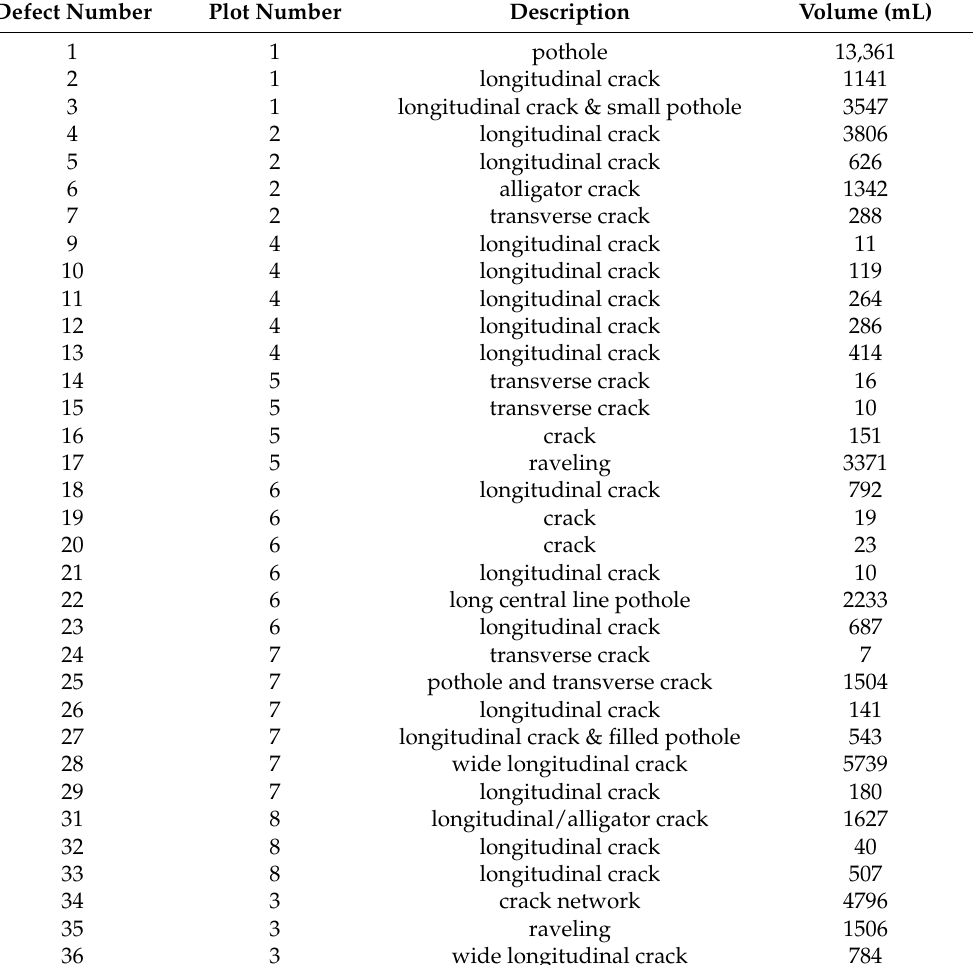
Table 12. Segmented individual defects and some of their properties. Defects 8 and 30 were discarded during processing. Volume computation is described in Section